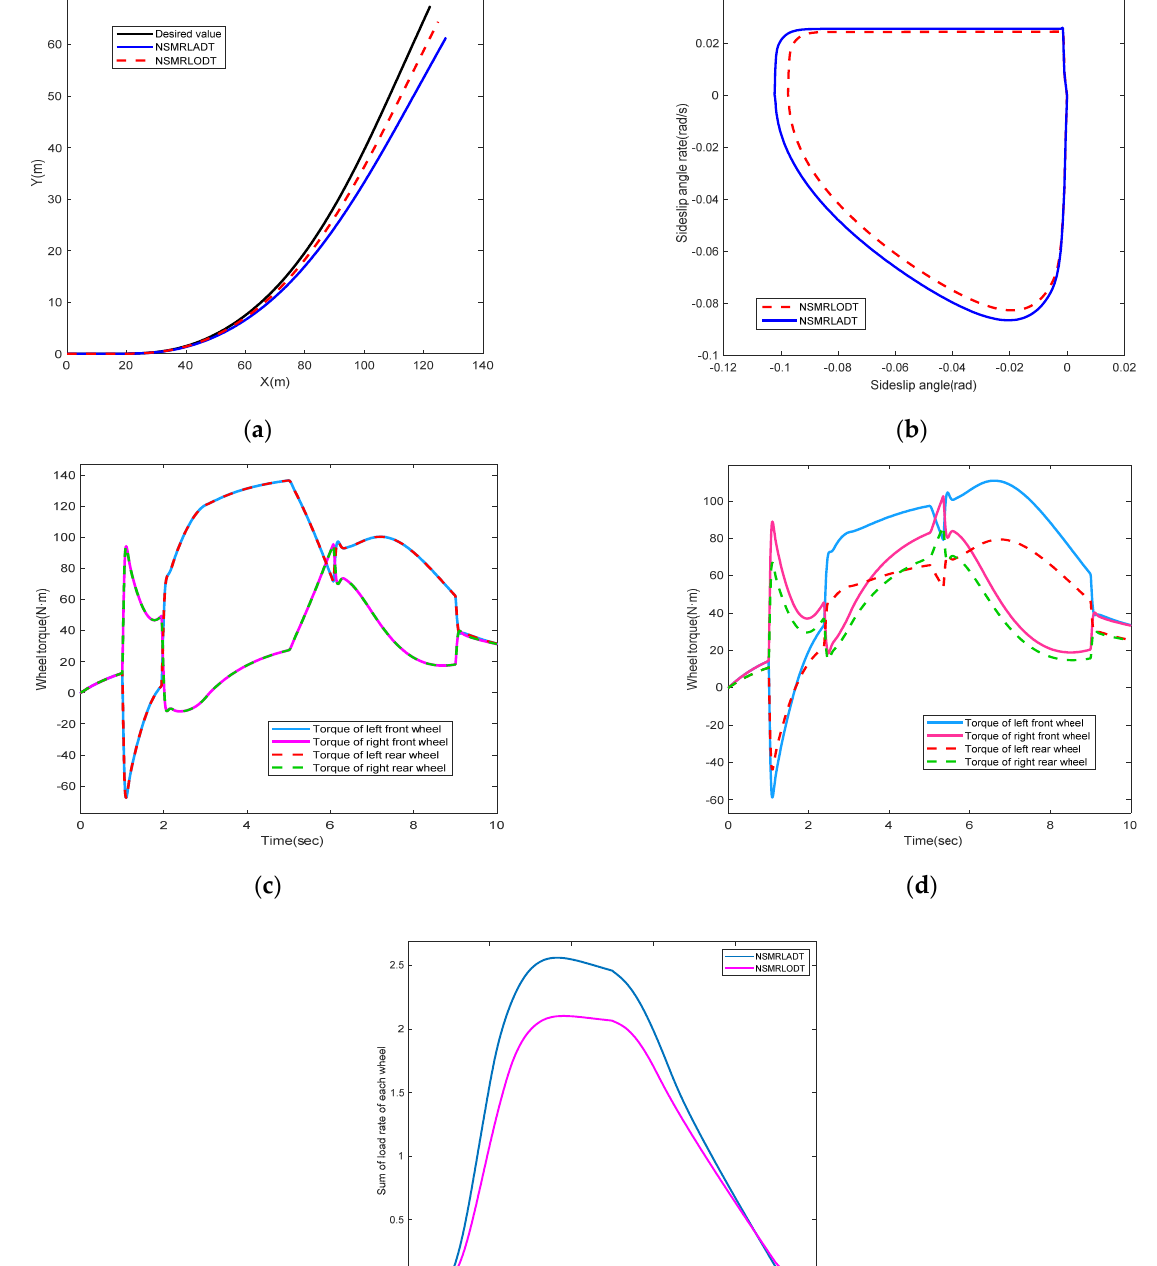
Figure 10. Simulation comparison of NSMRLADT and NSMRLODT under J-turn maneuver. ( a ) Vehicle trajectory; ( b ) β β− phase planes; ( c )ADT; ( d ) ODT; ( e ) total load rate of the four tires.